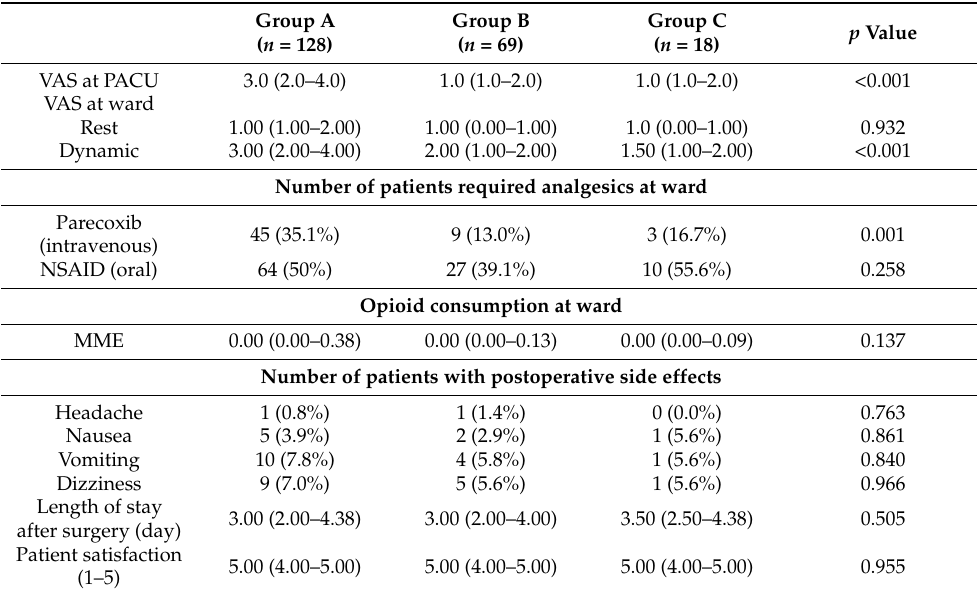
Table 3. Postoperative presentations of patients who underwent knee arthroscopic surgery un- der bispectral index-guided sevoflurane anesthesia without adductor canal block (Group A ), with preoperative ACB (Group B ), and with postoperative ACB (Group C